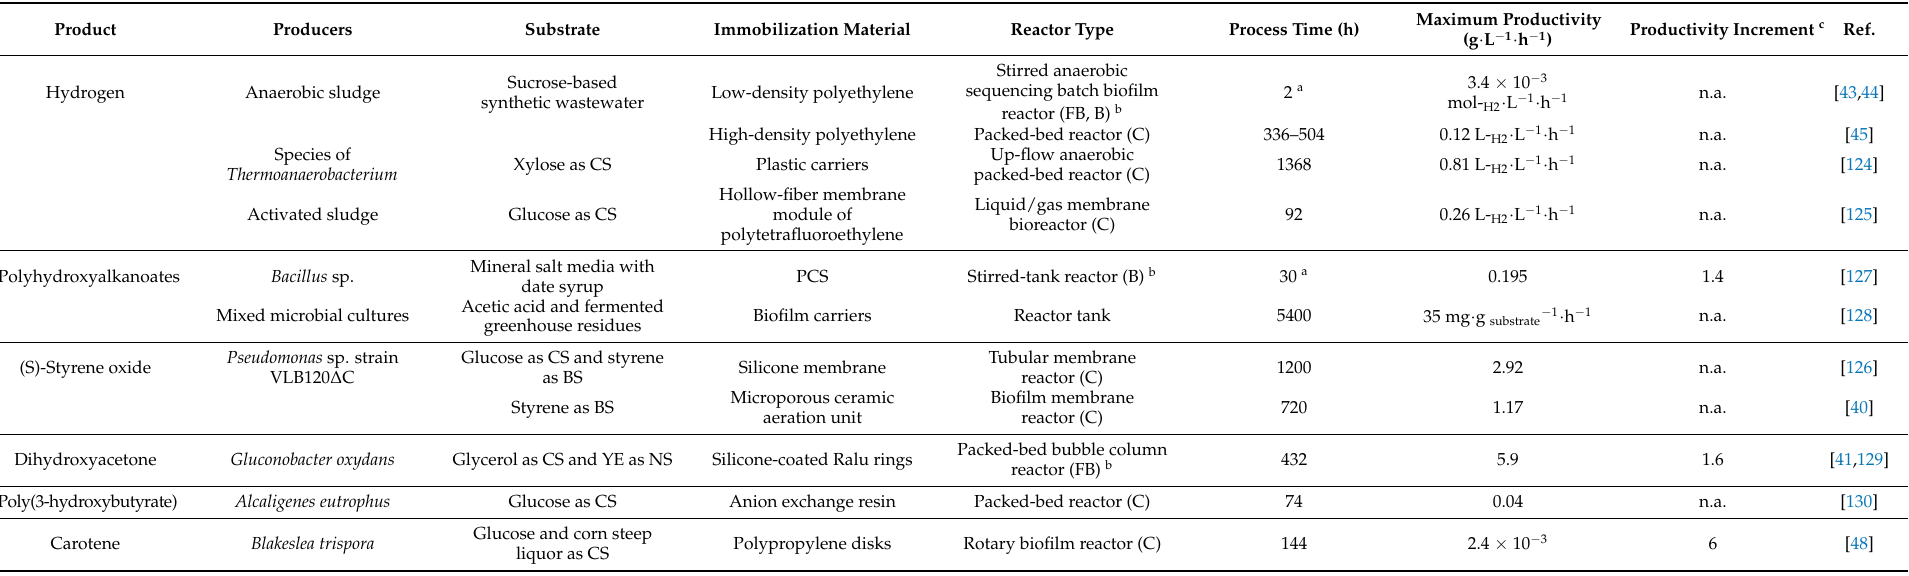
Table 6. Different classes of other added-value compounds produced in biofilm